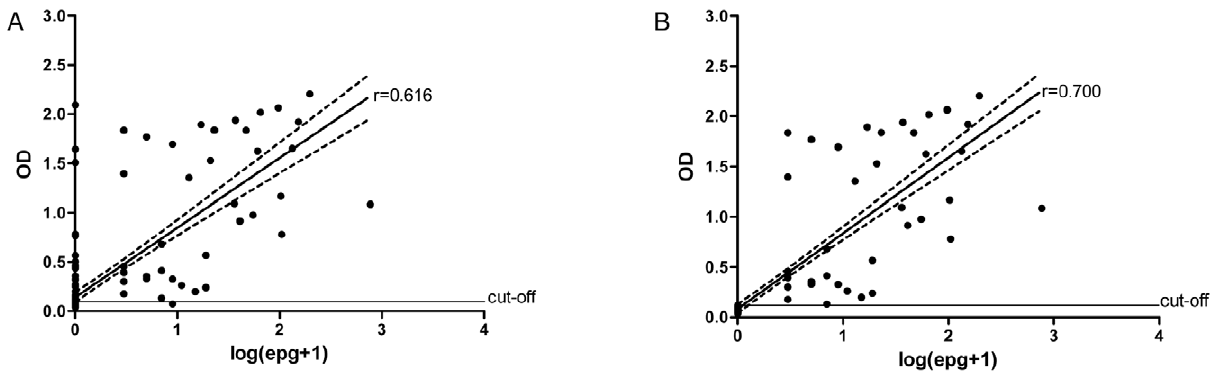
Figure 3. Correlation between log-transformed individual measurements of eggs per gram (epg) of feces and absorbance readings. A. A Spearman’s correlation coefficient of 0.616 ( P , 0.0001) was found for a comparison considering all 206 samples. B. Considering positive and negative samples for the Kato-Katz technique and the Schistosoma PCR-ELISA system, a Spearman’s correlation coefficient of 0.700 ( P , 0.0001) was observed. The continuous line represents the linear regression, and the hatched line represents the 95% CI.